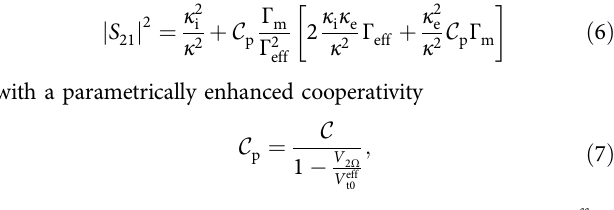
Γ = Γ . From fi ts to the data, shown as lines, we can extract V t0 eff m the instability threshold voltages, indicated as dashed vertical lines and plotted in the inset vs. effective mechanical linewidth. The threshold gets shifted towards higher values due to an increase of partly due to a microwave power-dependent intrinsic linewidth